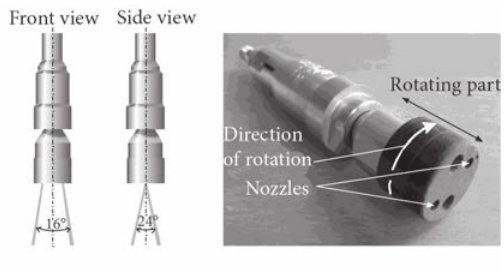
Table 2. Process parameters for different jet types